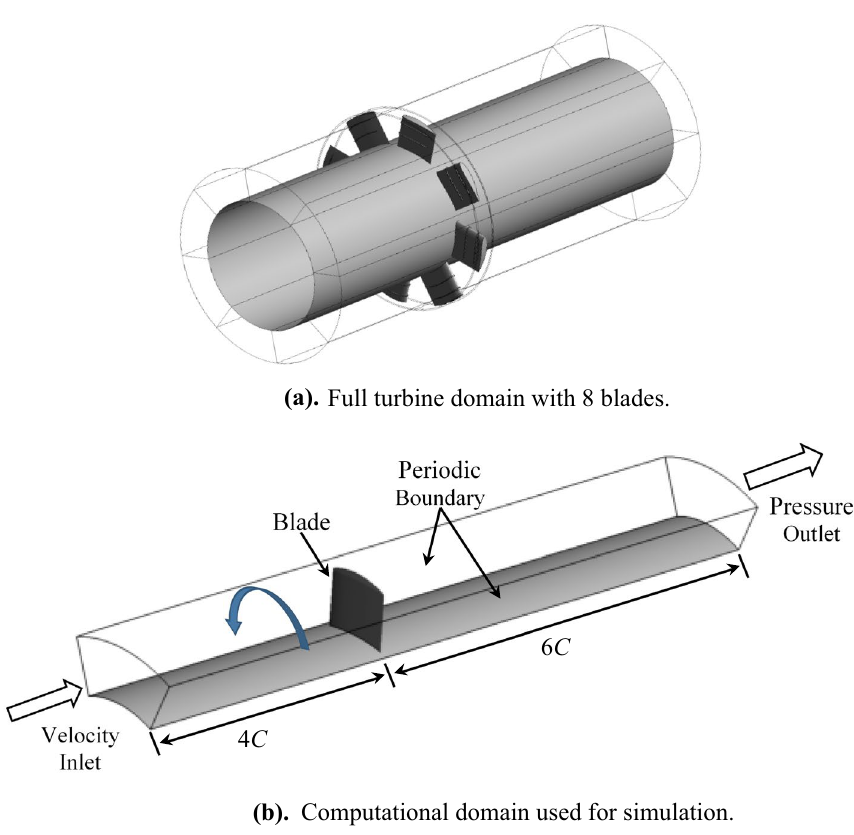
Figure 4. ( a ) Full turbine domain with 8 blades. ( b ) Computational domain used for